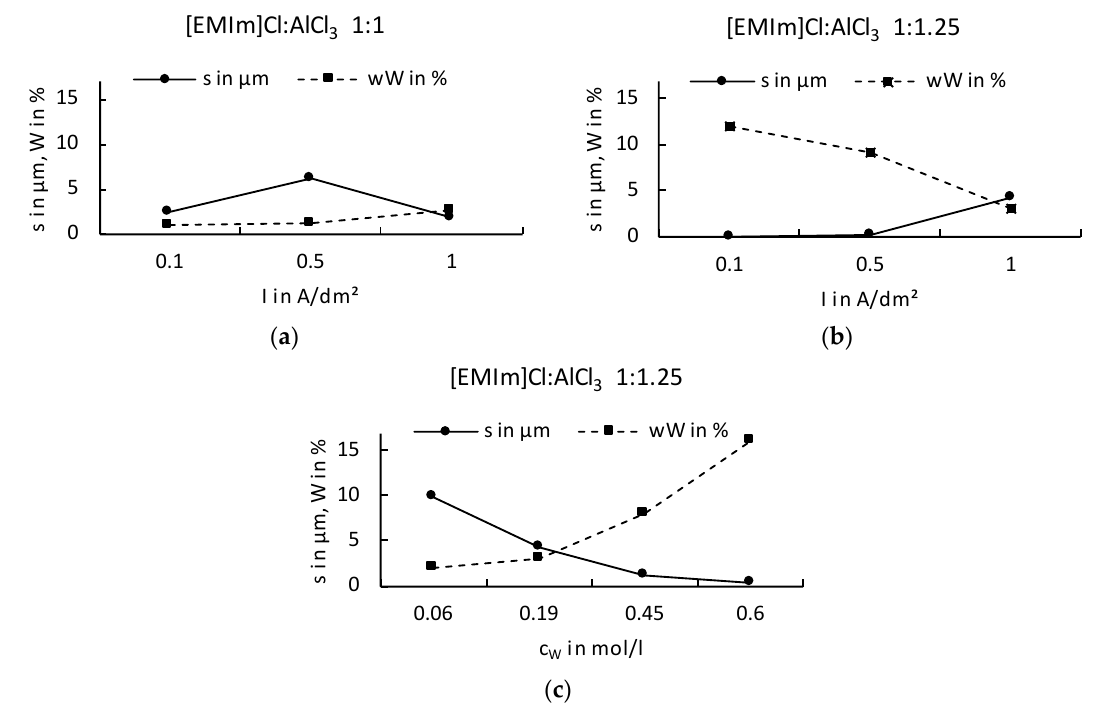
Figure 2. Ag–W depositions under direct-current from mixing ratios of [EMIm]Cl:AlCl 3 1:1 ( a ), 1:1.25 ( b ) and with different W concentrations in the electrolyte ( c ).